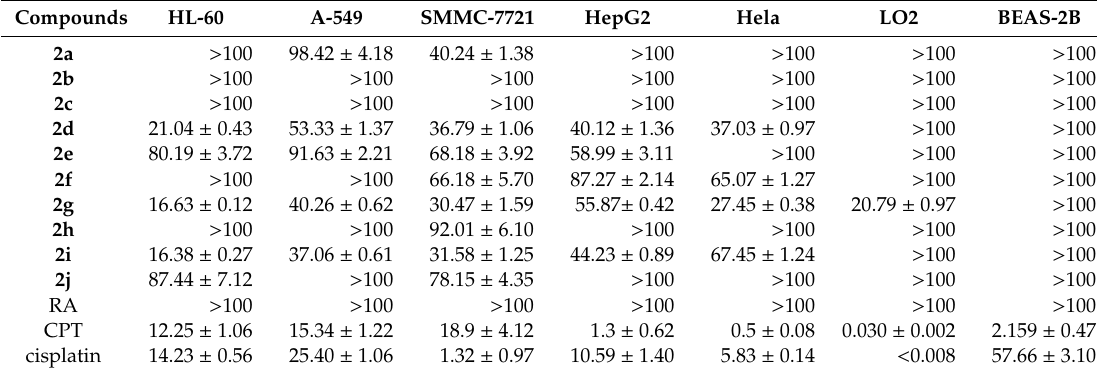
Table 1. IC 50 values of the synthesized compounds and controls obtained for anti-proliferative activity on di ff erent tumor cell lines ( µ